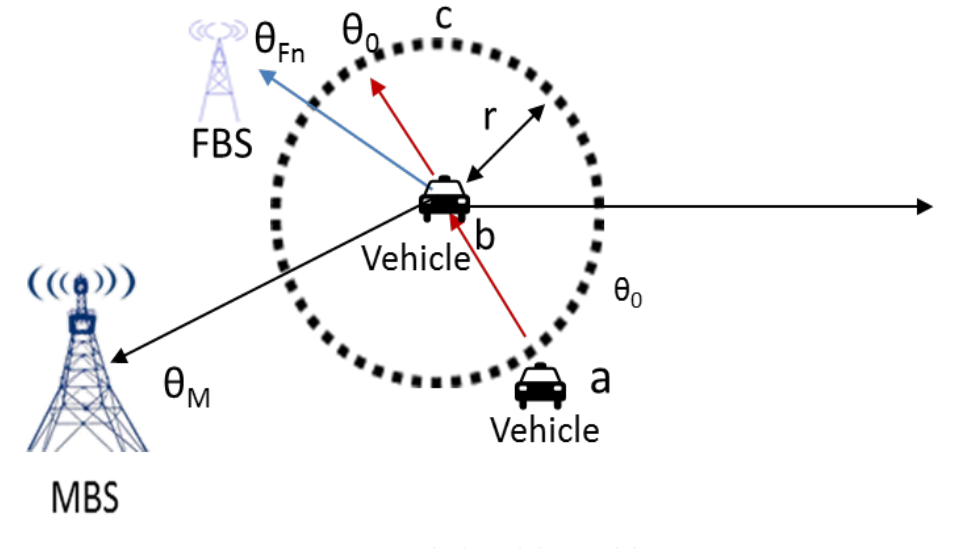
Figure 6. Vehicle-mobility